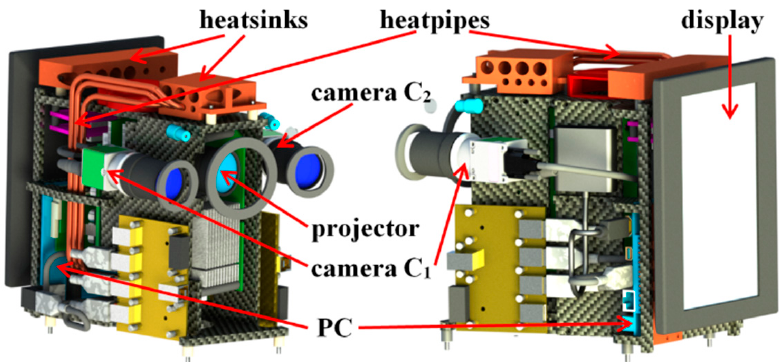
Figure 5. Principal components in two views of a construction drawing.